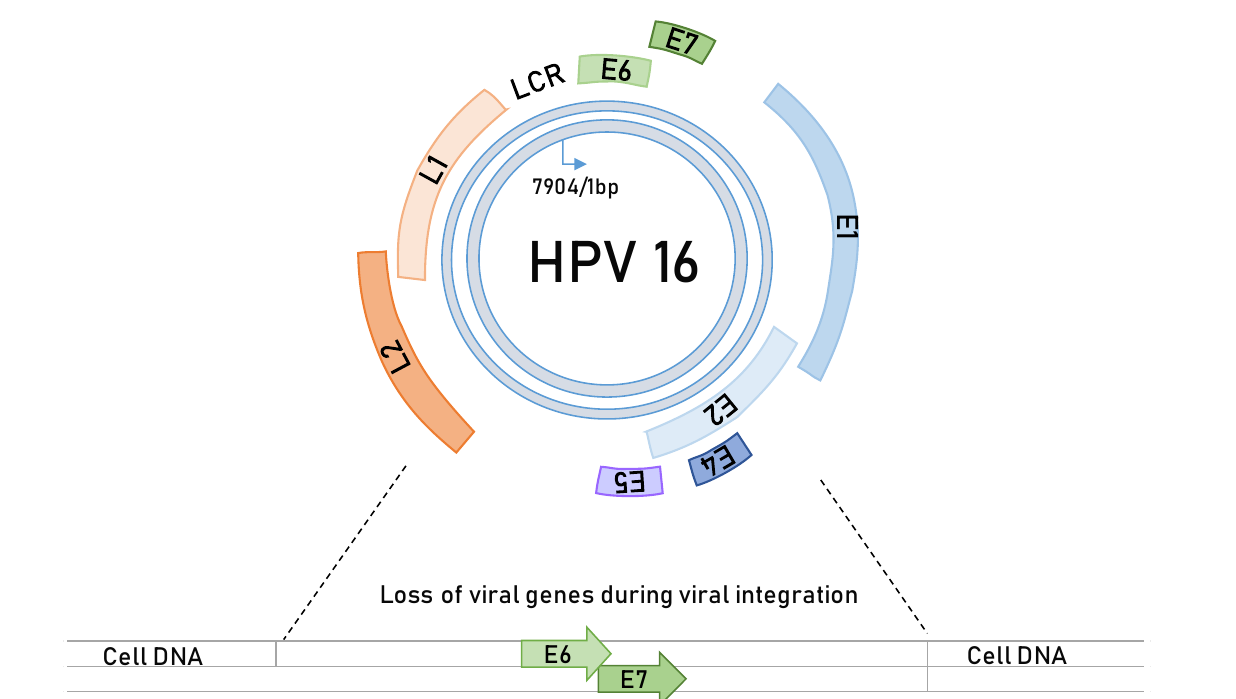
Figure 1. Schematic representation of HPV-16 genome. The episomal (circular) form of the viral genome comprises 7904 bp coding for a limited number of regulatory (E, early) and structural (L, late) viral proteins. LCR (long control region) is a noncoding region that regulates transcription of the viral genome. E1 codes for an ATPase (DNA-dependent adenosine triphosphatase) and DNA helicase, which serves to initiate DNA replication jointly with the E2 protein. In addition to starting replication, E2 acts as a transcriptional regulator together with the E2 response elements in the LCR. E4 serves to disrupt the keratin filaments in the upper layers of the epithelium, while E5 induces cell proliferation, angiogenesis, and apoptosis by regulating growth signalling pathways in addition to helping immune evasion. E6 oncoprotein promotes apoptosis evasion and cell-cycle deregulation. E7 promotes uncontrolled proliferation and, together with E6, induces malignant transformation. L1 and L2 genes code for viral capsid proteins, which are expressed only in the late phase of the viral life cycle. HPV DNA integration into a host cell genome is random event although it often occurs close to common fragile sites. Upon integration, most of the regulatory genes (E1, E2, E4, and E5) and the capsid genes (L1 and L2) are lost, but two main oncogenes, E6 and E7, remain uncontrollably expressed and are no longer under negative control of the E2 protein. This gives the cells integrated HPV genomes and a selective growth advantage and promotes the development of cancer.